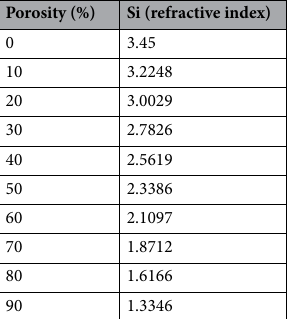
Table 1. Effective refractive index of silicon with various porosity